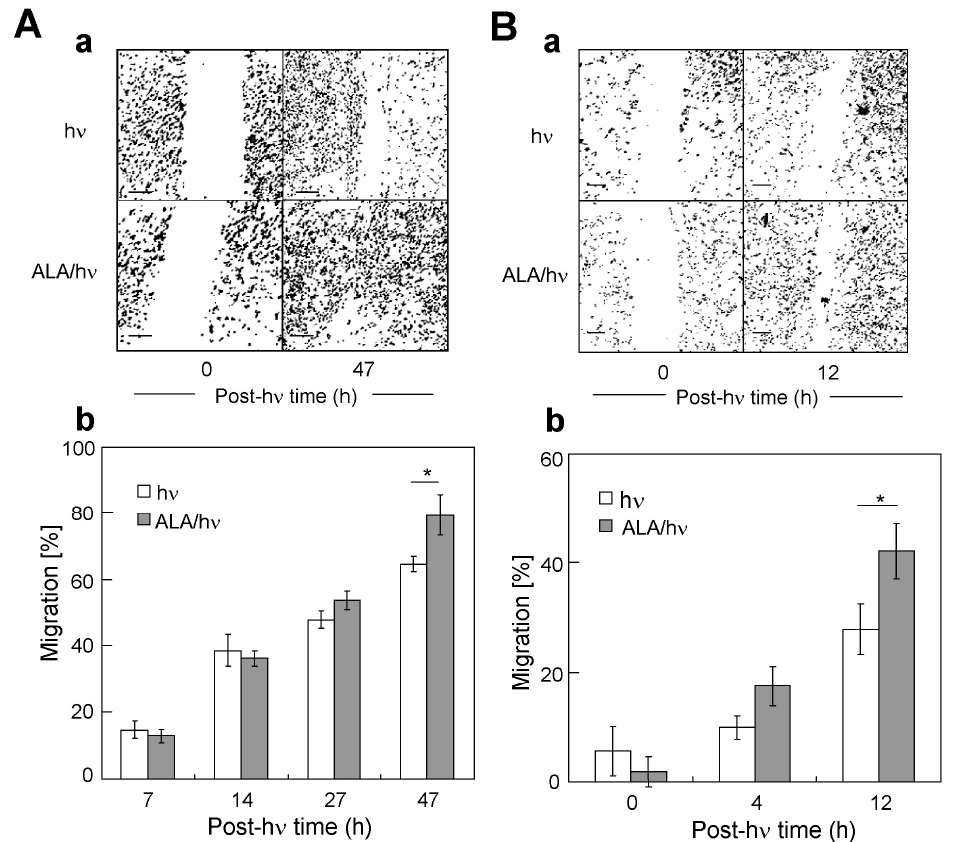
Figure 3. ( A ) Enhanced migration of surviving ALA/light-targeted MDA-MB-231 cells. Immediately after irradiation as described in Figure 1, cells were switched to serum-containing medium, and a linear scratch was made across a selected region of the targeted cell population. The span of the resulting gap was then then monitored over a 2-day dark incubation period. Controls (h ν ) were monitored alongside. ( a ) Photographs of targeted cell gap zones obtained at 0 h and 47 h after irradiation. ( b ) Extent of targeted cell migration as a function of post-irradiation time. ( B ) Enhanced migration of MDA-MB-231 bystander cells after target cell ALA/light treatment. Immediately after irradiation, separating rings were removed and a linear scratch was made across each bystander group, followed by evaluation of the resulting gap size over a 12 h incubation period. ( a ) Photographs of gap zones at 0 h and 12 h after target cell challenge. ( b ) Plot of bystander migration as a function of post-h ν time. Plotted values in ( A ) and ( B ) are means ± SEM ( n = 5); * p < 0.05 vs. light-only controls.